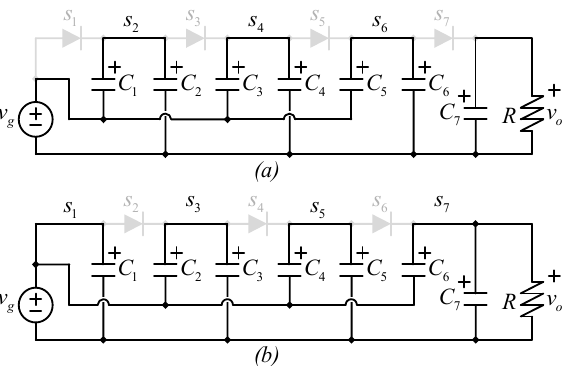
Figure 5. Equivalent circuits of the multiplier in Figure 4. ( a ) First equivalent circuit when v 1 is high and v 2 is low, and ( b ) second equivalent circuit when v 2 is high and v 1 is low.